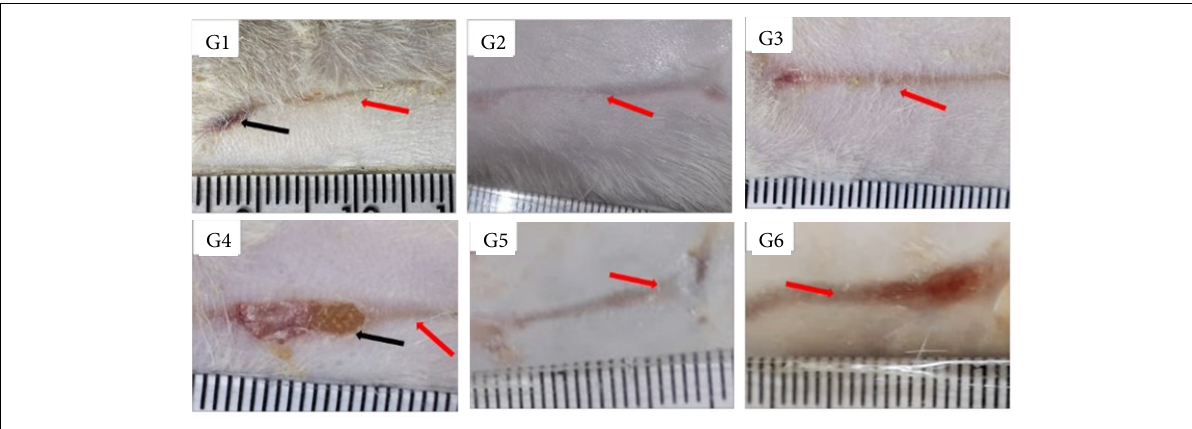
Figure 3 - Macroscopic aspects of partial thickness burn wounds experimentally induced in Wistar rats treated with silver-based dressings through 30